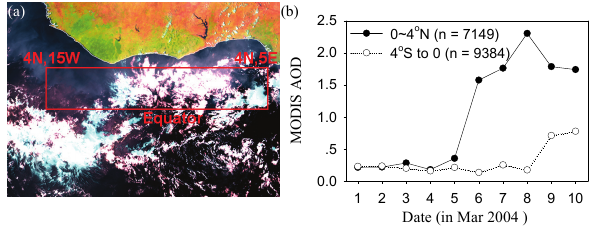
Fig. 1. (a) Meteosat-8 RGB composite image over the northeast Figure 1. (a) Meteosat-8 RGB composite image over the northeast Atlantic Ocean at 10 Atlantic Ocean at 13:42UTC on 7 March 2004. (b) Time series of domain averaged aerosol optical depth derived from MODIS during 13:42 UTC on March 7 2004. (b) Time series of domain averaged aerosol optical depth 11 1 to 10 March 2004 for the domains of (0 ∼ 4 ◦ N, 15 ◦ W ∼ 5 ◦ E) and derived from MODIS during 1 to10 March 2004 for the domains of (0~4°N, 15°W~5°E) 12 (0 ◦ ∼ 4 ◦ S, 15 ◦ W ∼ 5 ◦ and (0°~4°S, 15°W~5°E). 13